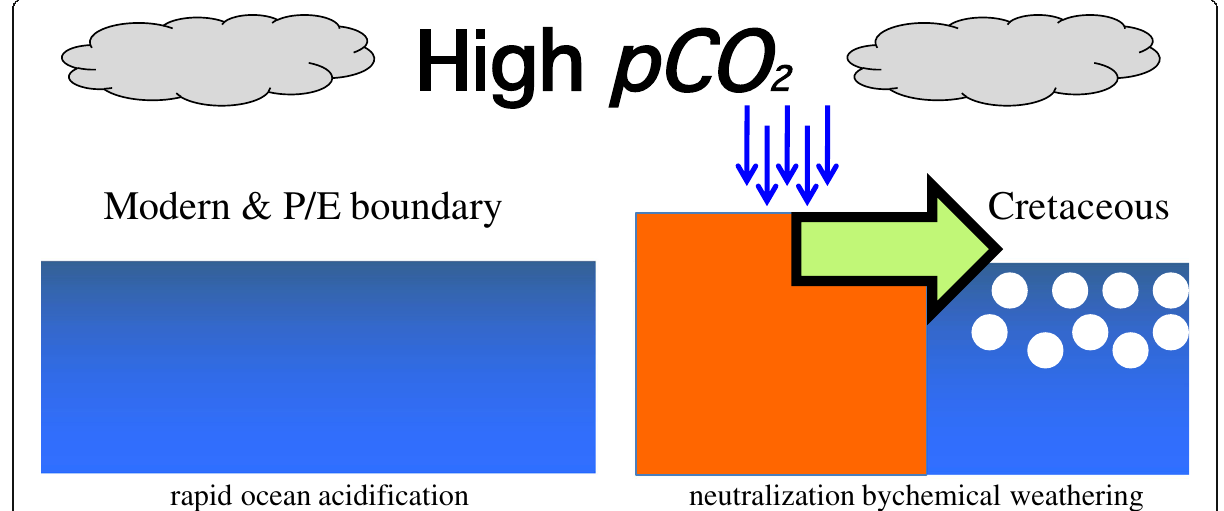
Fig. 20 Schematic diagram of ocean acidification and the buffering system in the Earth ’ s surface system. Chemical weathering is important and acts as a neutralizing process. The level of CO 2 is a secondarily important factor. The most important factor is “ Changing SPEED. ” A natural neutralizing system such as chemical weathering cannot catch up too rapid a global environmental change under modern conditions or at the P/E boundary (Kawahata et al.